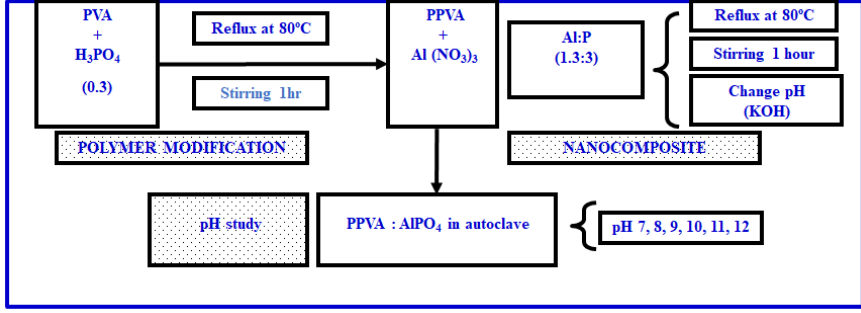
Figure 1. Flowchart of synthesis and characterization of PPVA-AlPO 4 nanocomposites. Table 1. Visual observation of as prepared and heat-treated samples at 120 °C for various pH values.